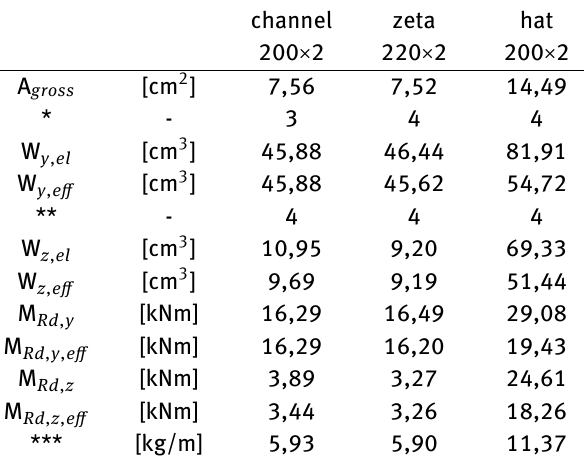
Table 2: Results of calculations, elements without longitude stiffen-